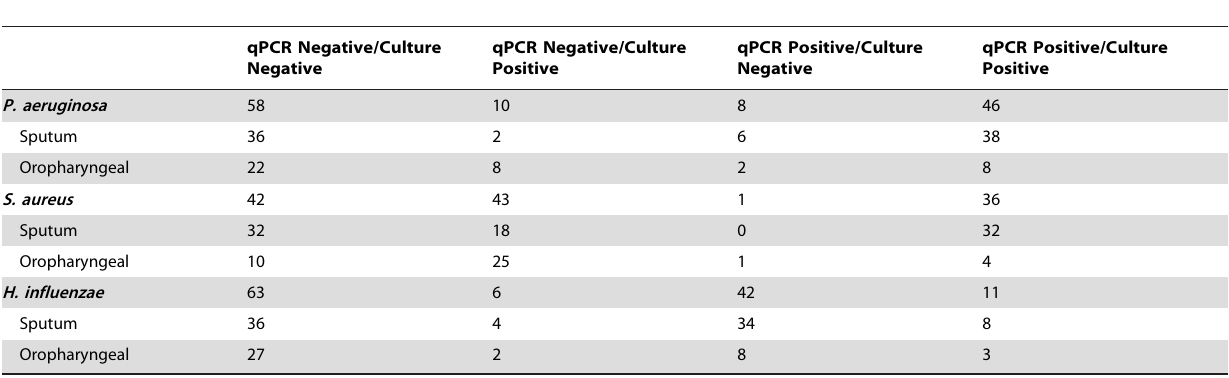
Table 3. Cross-tabulation of qPCR and standard microbial culture results for typical CF pathogens (N =122 airway specimens consisting of 82 sputa and 40 oropharyngeal specimens).